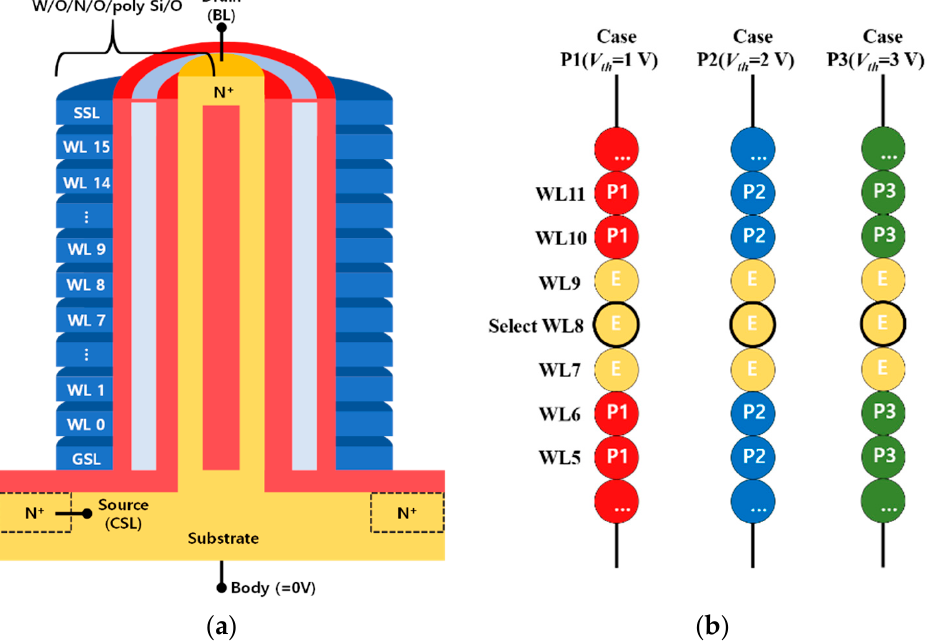
Figure 1. ( a ) Structure of 3D NAND flash memory and ( b ) simulation pattern according to the V th of the adjacent cell.